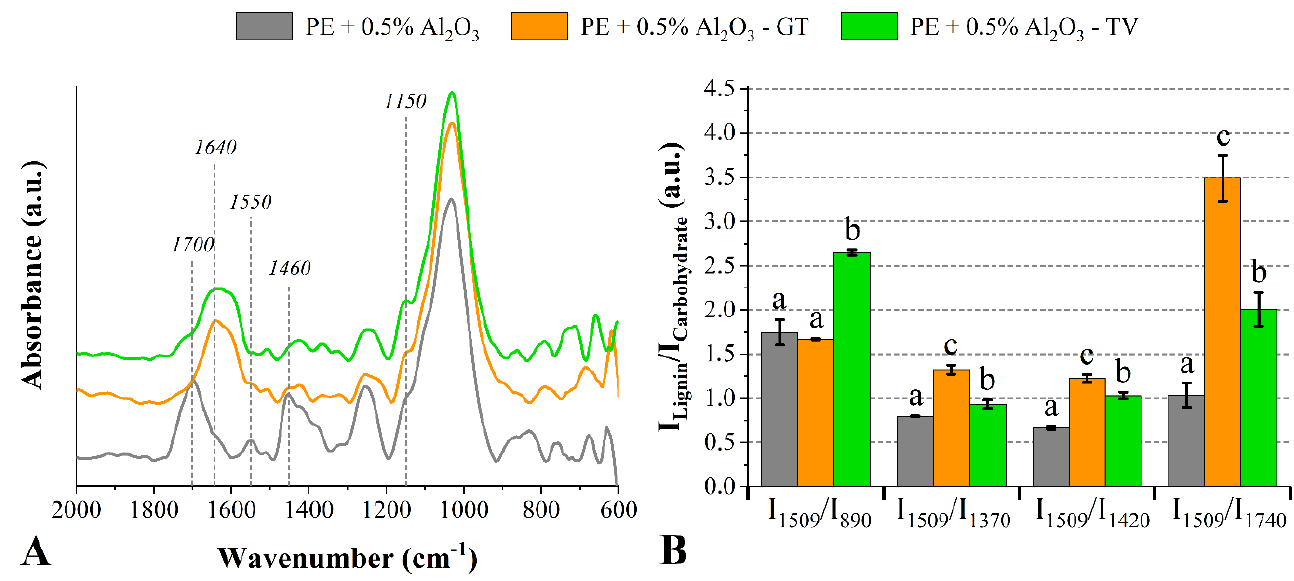
Figure 5. FT − IR spectra ( A ) and lignin/carbohydrate ratios ( B ) of the P. elliottii (P E ) woods treated with 0.5% of Al 2 O 3 exposed to the G. trabeum and T. versicolor fungi. Where: Different letters above the bars indicate statistically different means for each lignin/carbohydrate ratio.